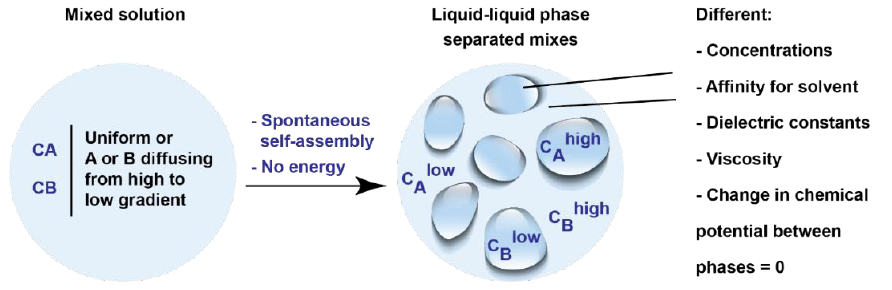
Figure 2. The consequences of LLPS in biological systems. CA, concentration of molecule A; CB, concentration of molecule B.